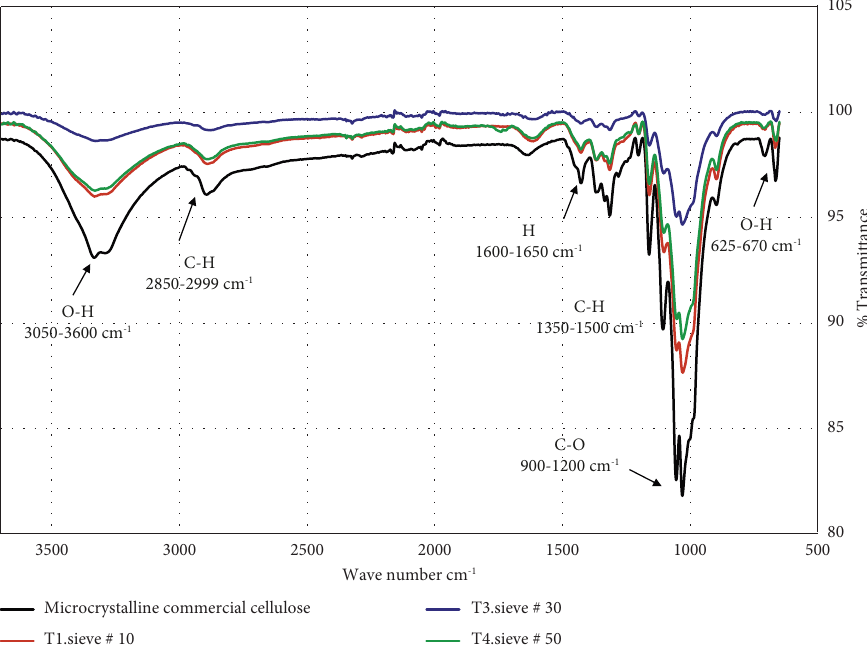
Figure 3: Cellulose comparison extracted from rice husk and characterized by Fourier transform infrared spectroscopy (FTIR). Commercial standard and three treatments cellulose samples processed with NaOH 5% and sieves # 10, 30, and 50. (source: the author himself).